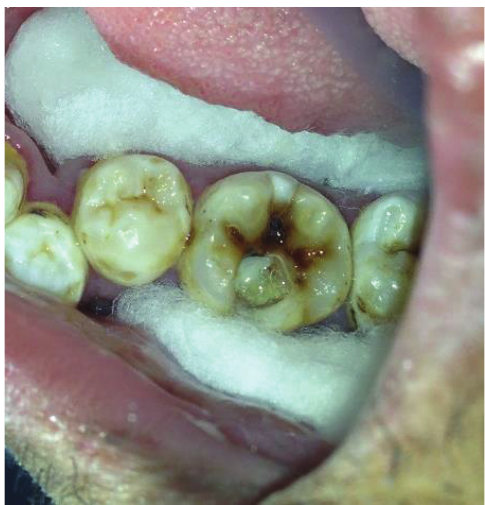
Figure 25: Preoperative photograph 36.